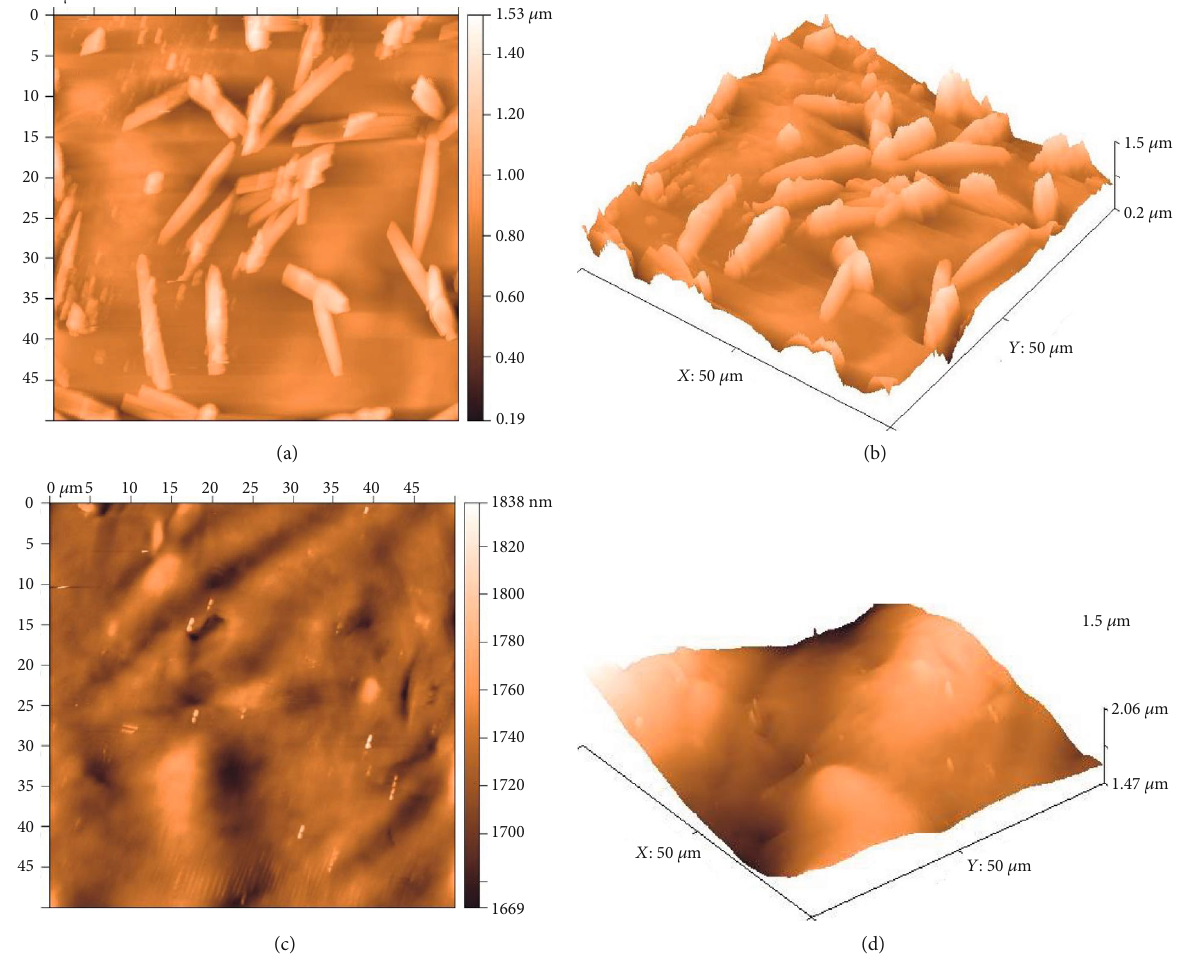
Figure 2: AFM micrograph of CNC fi lm: (a) 2D-AFM micrograph of CNC fi lm, (b) 3D-AFM micrograph of CNC fi lm, (c) 2D-AFM micrograph of CNC with glycerol, and (d) 3D-AFM micrograph of the same